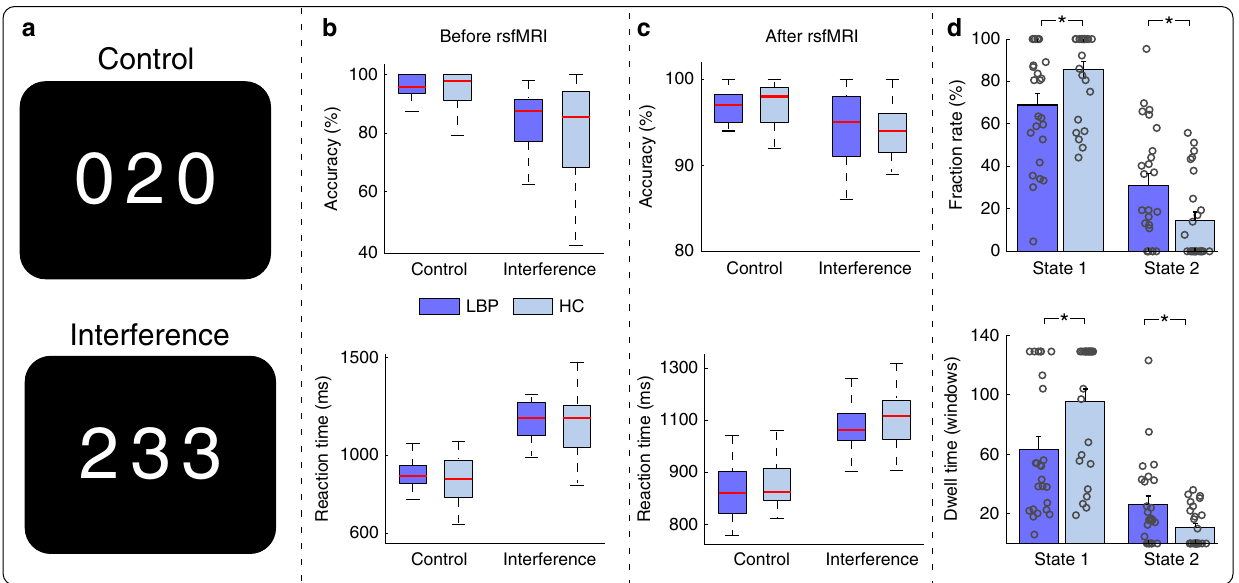
Fig. 6 MSIT behavior performance and dFNC occurrences. a MSIT trial examples. b Accuracy and reaction time for control and interference tasks before resting-state fMRI (rsfMRI) in cLBP and HCs. c Accuracy and reaction time for control and interference tasks after rsfMRI in cLBP and HCs. d Group differences of occurrences in cLBP and HCs. N = 25 and 25 for cLBP patients and HCs, respectively. The boxes in b and c represent the 25th and 75th percentiles, and the red line represents the median of scores for accuracy or reaction time. The bars and errorbars in d represent the mean and SEM. Each circle represents the data for an individual. Asterisks represent signi fi cant differences at two-sided p FDR < 0.05 for t -test. Source data are provided as a Source Data fi